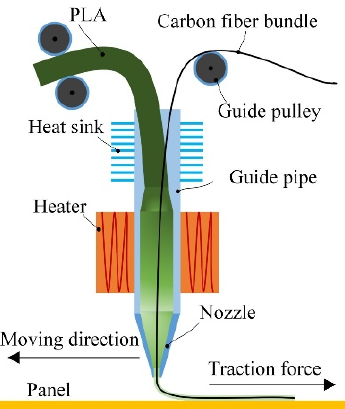
Figure 6. Principle of extrusion device to printing continuous carbon fiber-reinforced PLA. Reprinted from [59] with permission from Elsevier.